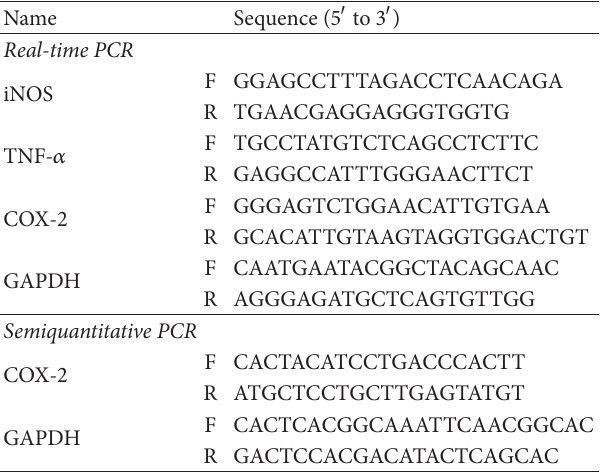
Table 1: PCR primers used in this